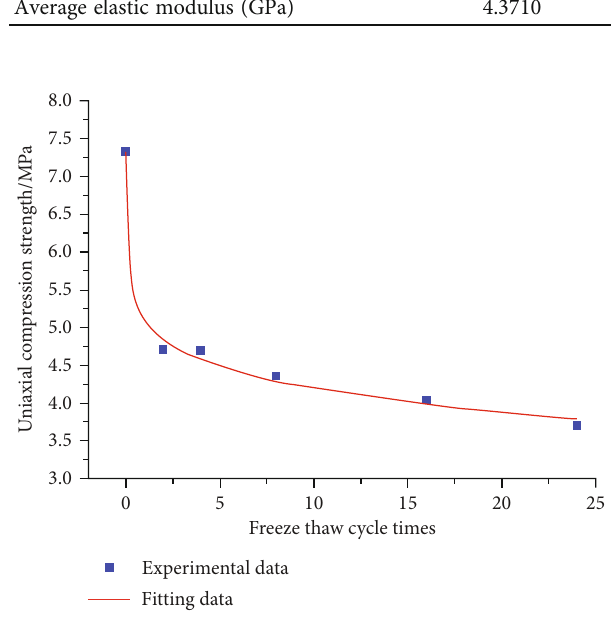
Figure 10: Variation of freeze-thaw cycles on the uniaxial compressive strength of oil shale samples.